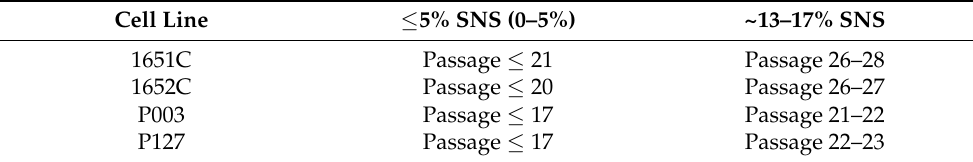
Table 1. Passage numbers for each cell line corresponding to the indicated senescence index (SNS). Cell